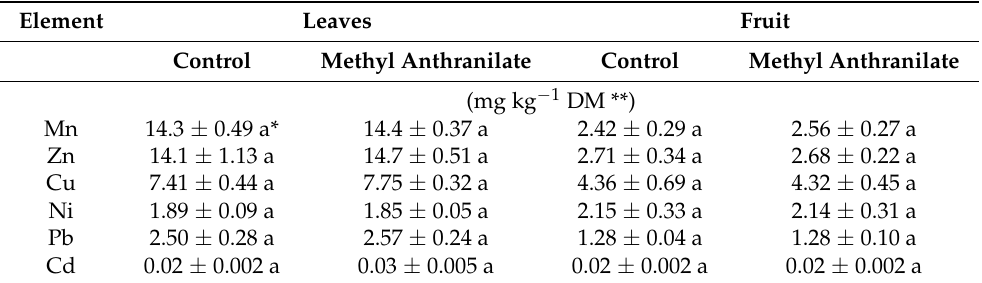
Table 3. The influence of methyl anthranilate on content of micronutrients, lead, and cadmium in leaves and fruit of sweet cherry cv. ‘Burlat’.